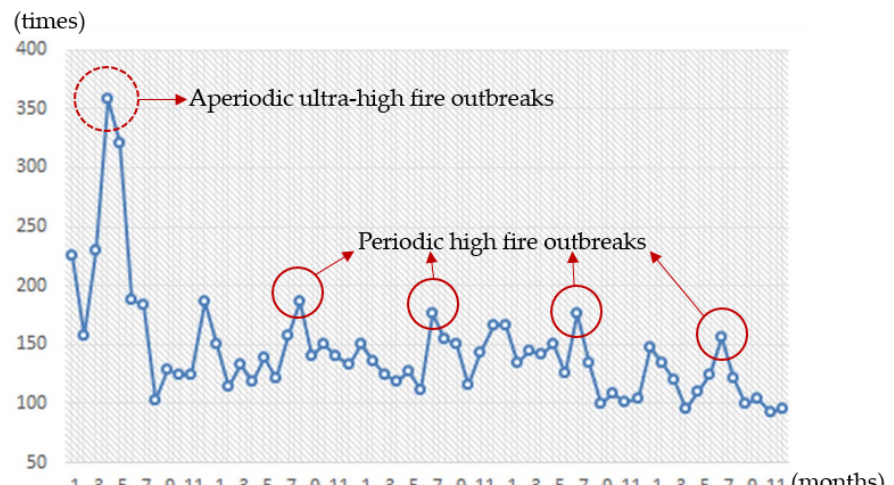
Figure 5. Fire outbreaks by month.